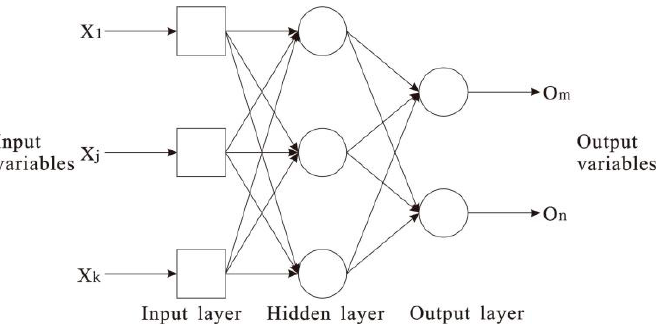
Figure 3. Feedforward architecture of artificial neural networks (modified using Ref. [21]).